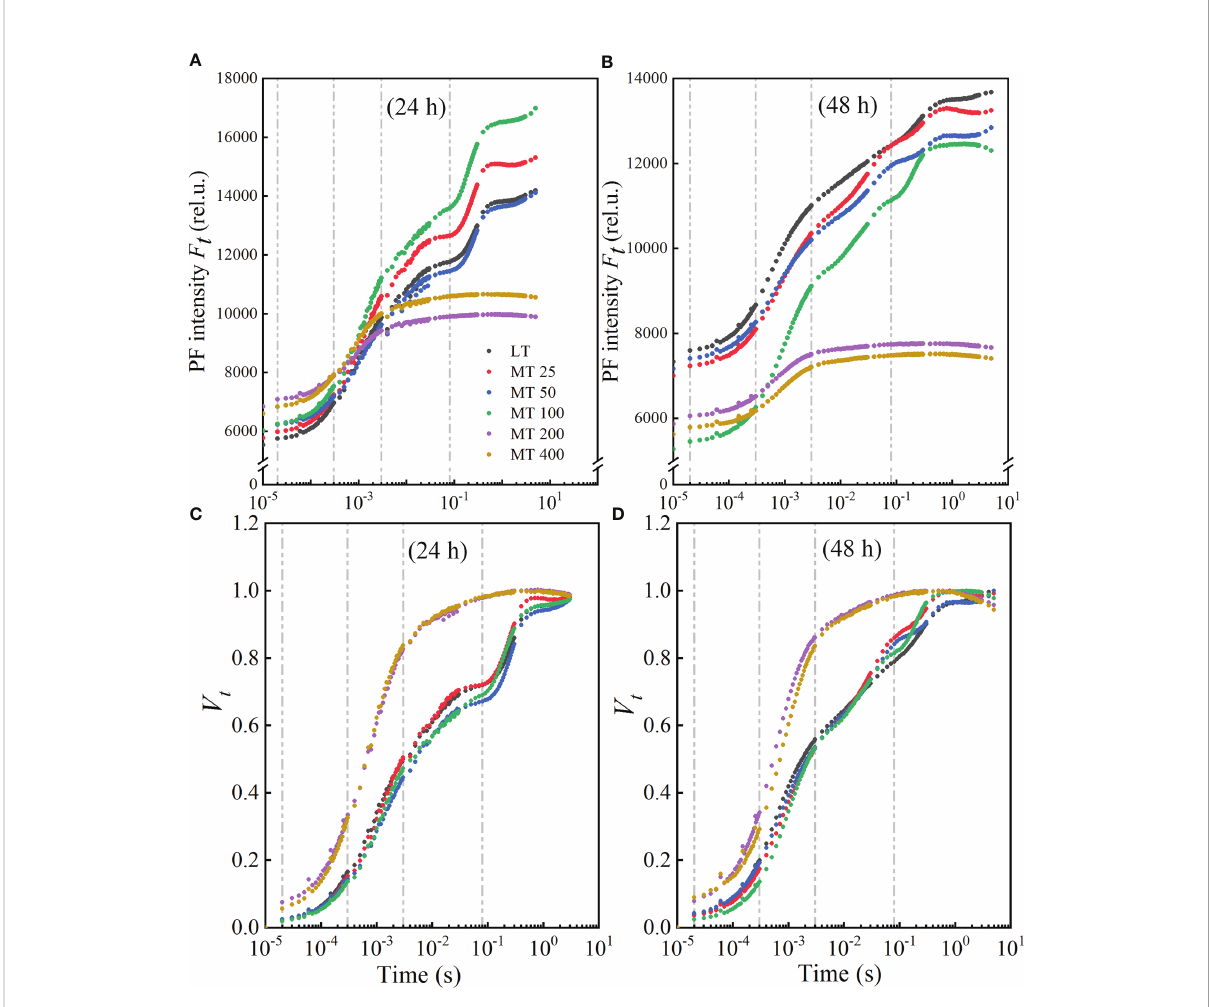
FIGURE 2 Effect of different melatonin (MT) concentrations on the induction of fl uorescence transient (OJIP) of the cucumber seedlings under low temperature stress. The OJIP transients after low temperature stress for 24 h (A) and 48 h (B) ; Normalized transients of OJIP in cucumber seedlings after low temperature for 24 h (C) and 48 h (D) . The V t was calculated as V t = [( F t − F O )/( F M − F O